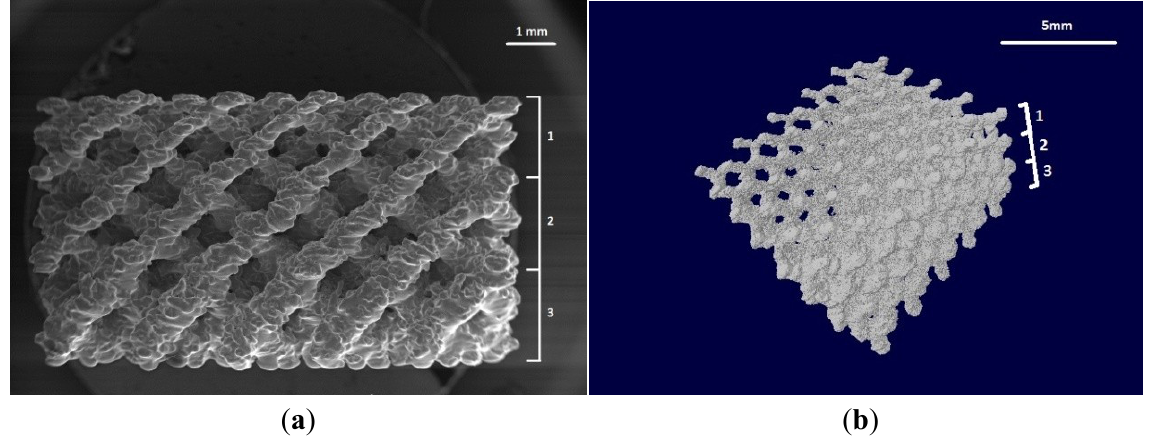
Figure 1. Images of graded lattices. ( a ) Secondary electron SEM Image; ( b ) 3D reconstruction of a micro CT scan. Numbers 1–3 correspond to the smallest to the largest strut thickness respectively.